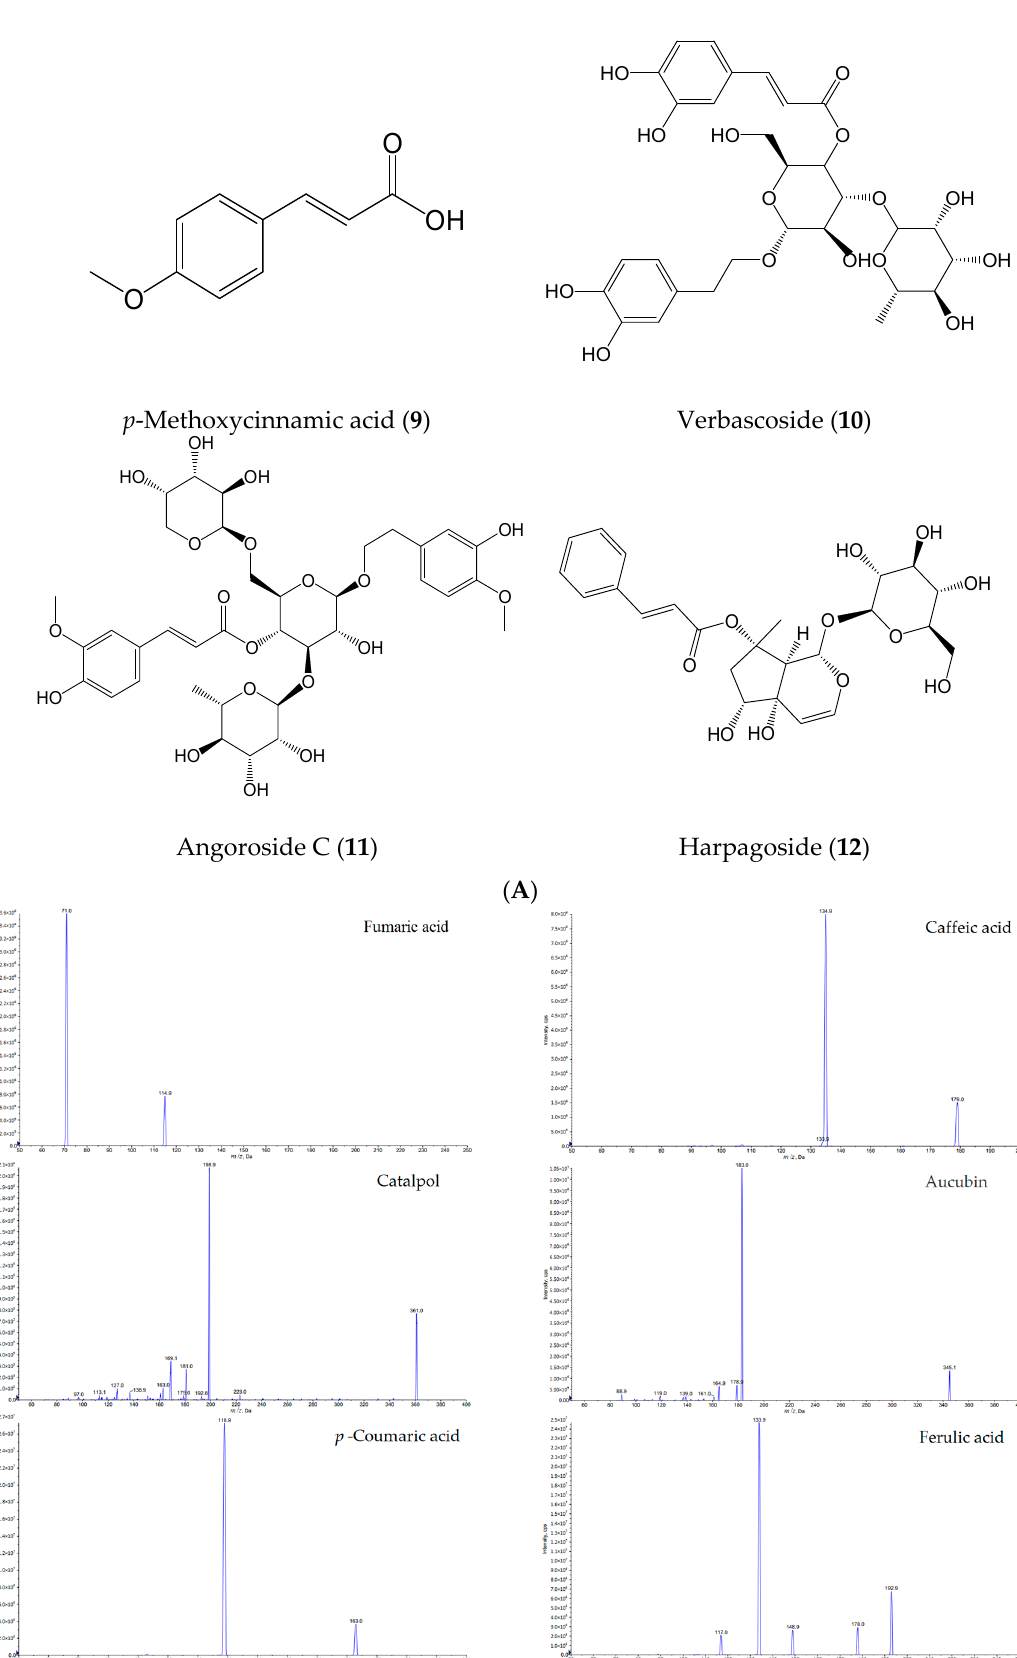
Figure 2. Cont. Figure 2.